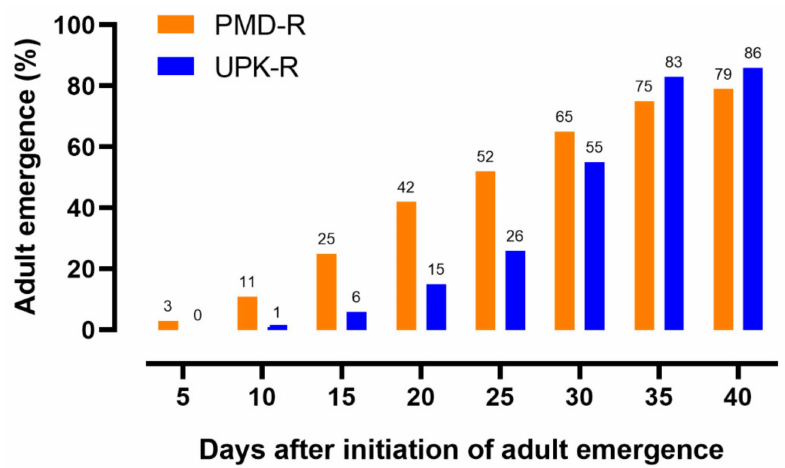
Figure 4. Cumulative adult emergence from the first appearance until the last emergence of PMD-R and UPK-R strains when they were reared together under limited space and food. The percentages of emerging adults are indicated above each bar.